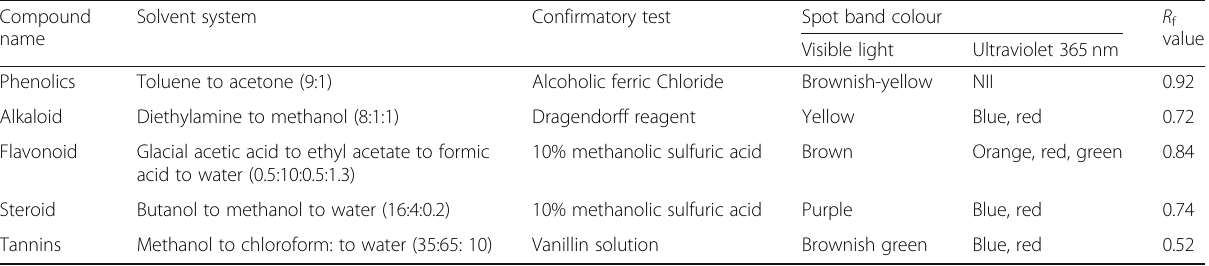
Table 2 Thin layer chromatography of hydro-methanolic extract of Sterculia urens Roxb. root